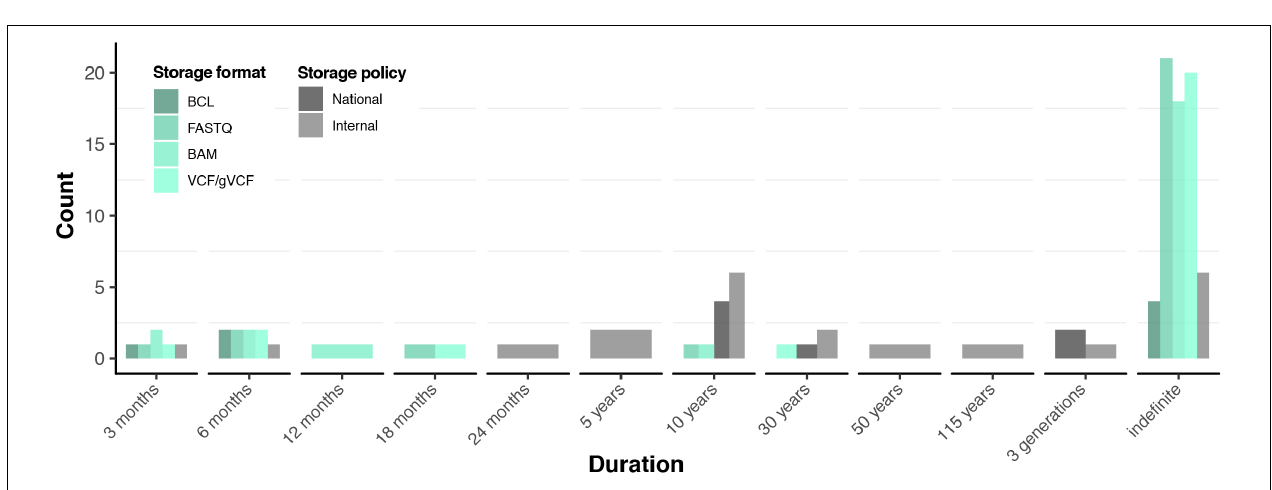
FIGURE 2 | Actual vs. potential sequencing capacity. (A) Number of whole exomes (WES) and whole genomes (WGS) sequenced per year. (B) Total number of WES and WGS sequenced to date. In (A,B) , the number of respondents that were able to estimate the number of WES and WGS sequenced individuals are indicated in grey text within the bars. (C) Annual predicted (70%) potential vs. actual sequencing capacity. Detailed information available in Supplementary File 2: Tables S3, S4 .